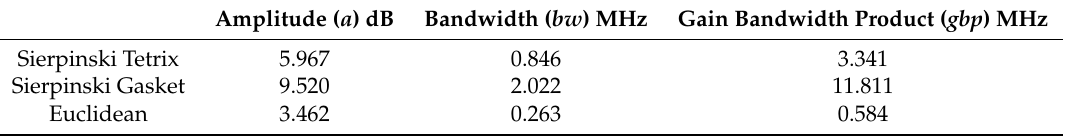
Table 3. Figure of merits for the Euclidean, Sierpinski gasket and tetrix pre-fractal sensors at generation level five. The bandwidth of all devices has been calculated using the amplitude at the resonant frequency of the Euclidean